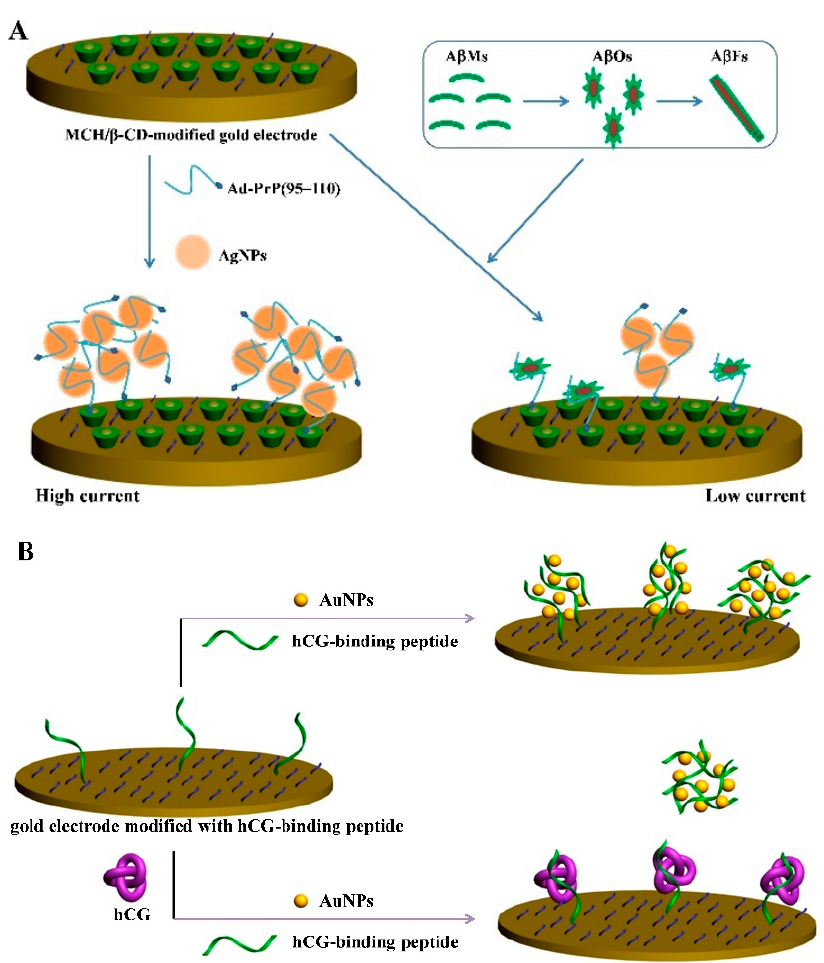
Figure 8. ( A ) Schematic representation of the electrochemical method for the selective detection of A β Os using AgNPs as the redox reporters and Ad-PrP(95 − 110) as the receptor [78]. Copyright 2016 American Chemical Society. ( B ) Schematic illustration of the electrochemical method for hCG detection using a peptide probe as the receptor of hCG and the inducer of AuNPs assembly [79]. Copyright 2017 Elsevier B.V.